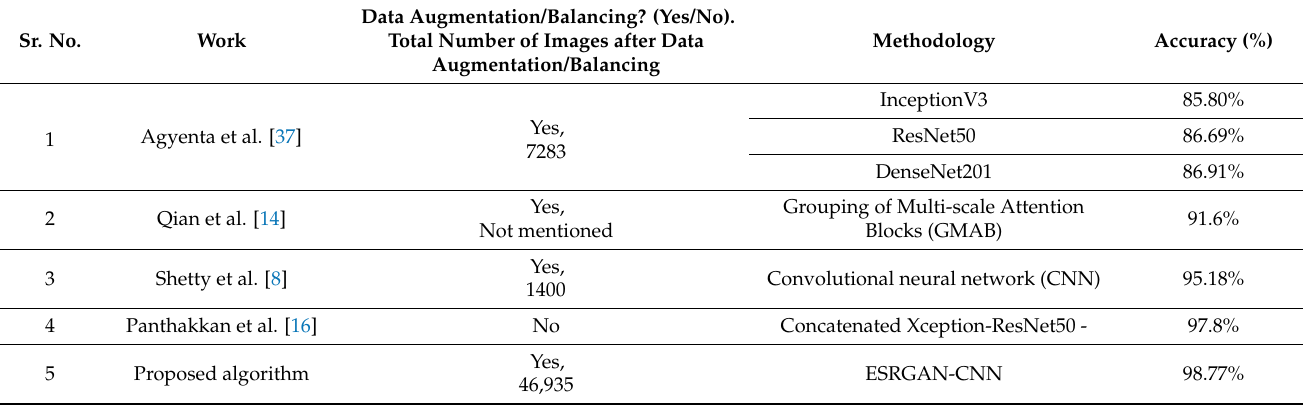
Table 8. Highest Accuracy for